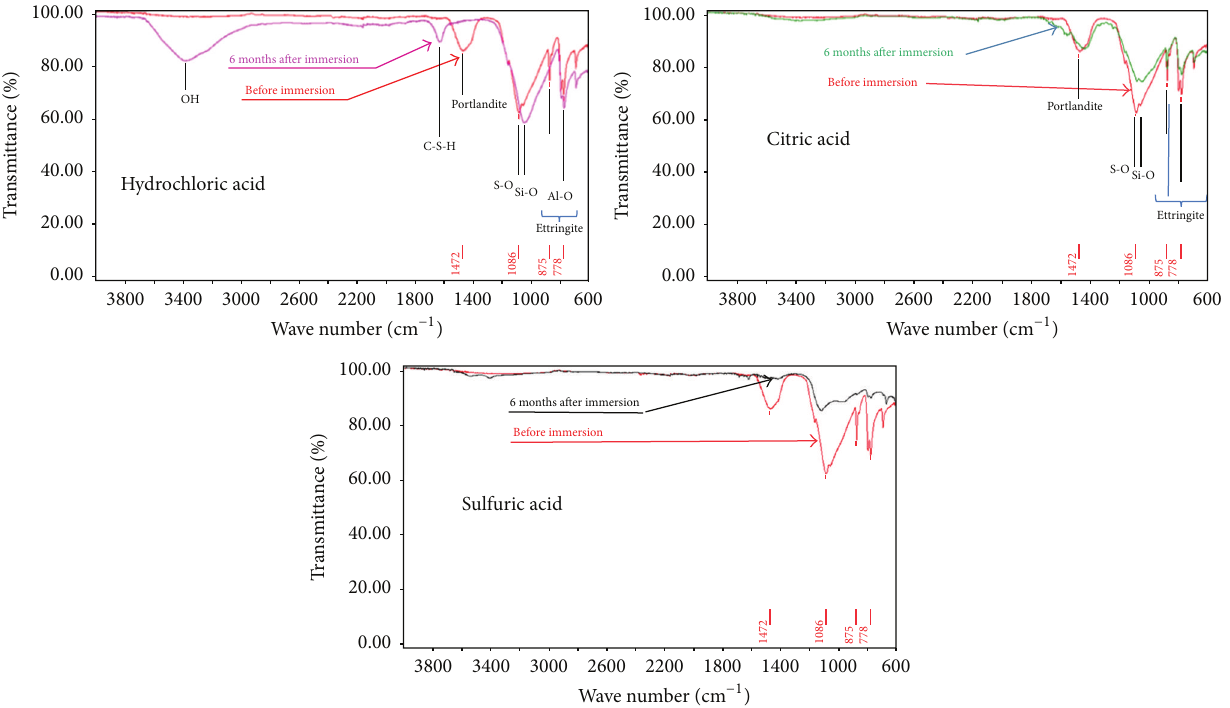
Figure 15: FTIR spectra of MCC before and after 6 months of exposure to the selected acid